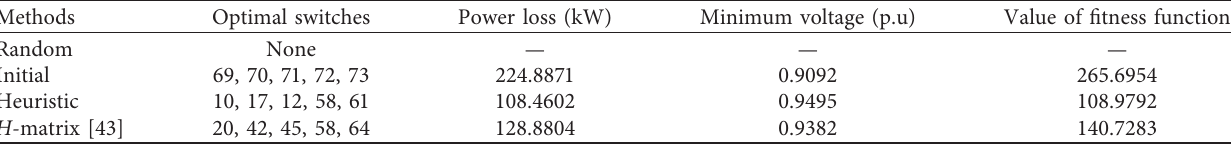
Table 4: The initial solution attached to the initial population for the 69-node